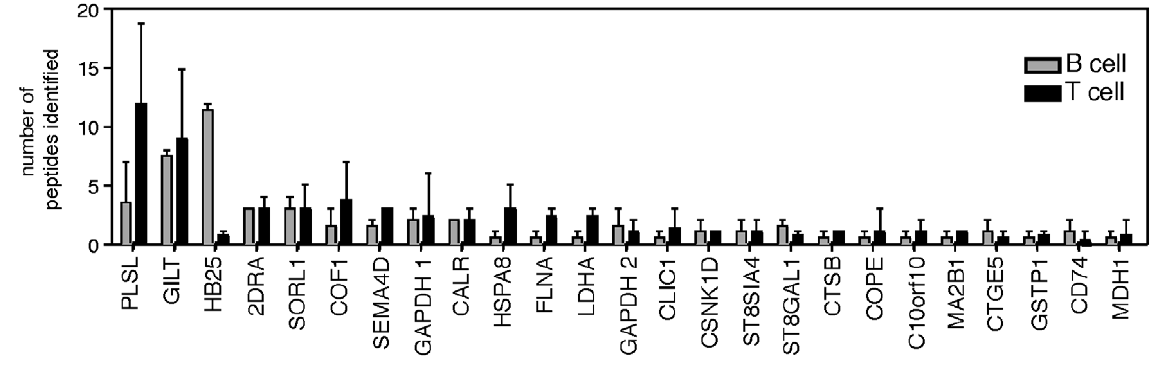
Figure 2. Total number of peptides identified from common proteins in the T cell and B cell self-presentation repertoire. Experiments were performed in triplicate (for T cell clones) and in duplicate (for B cell lines) using cells prepared from donor 1 (mean 6 range).